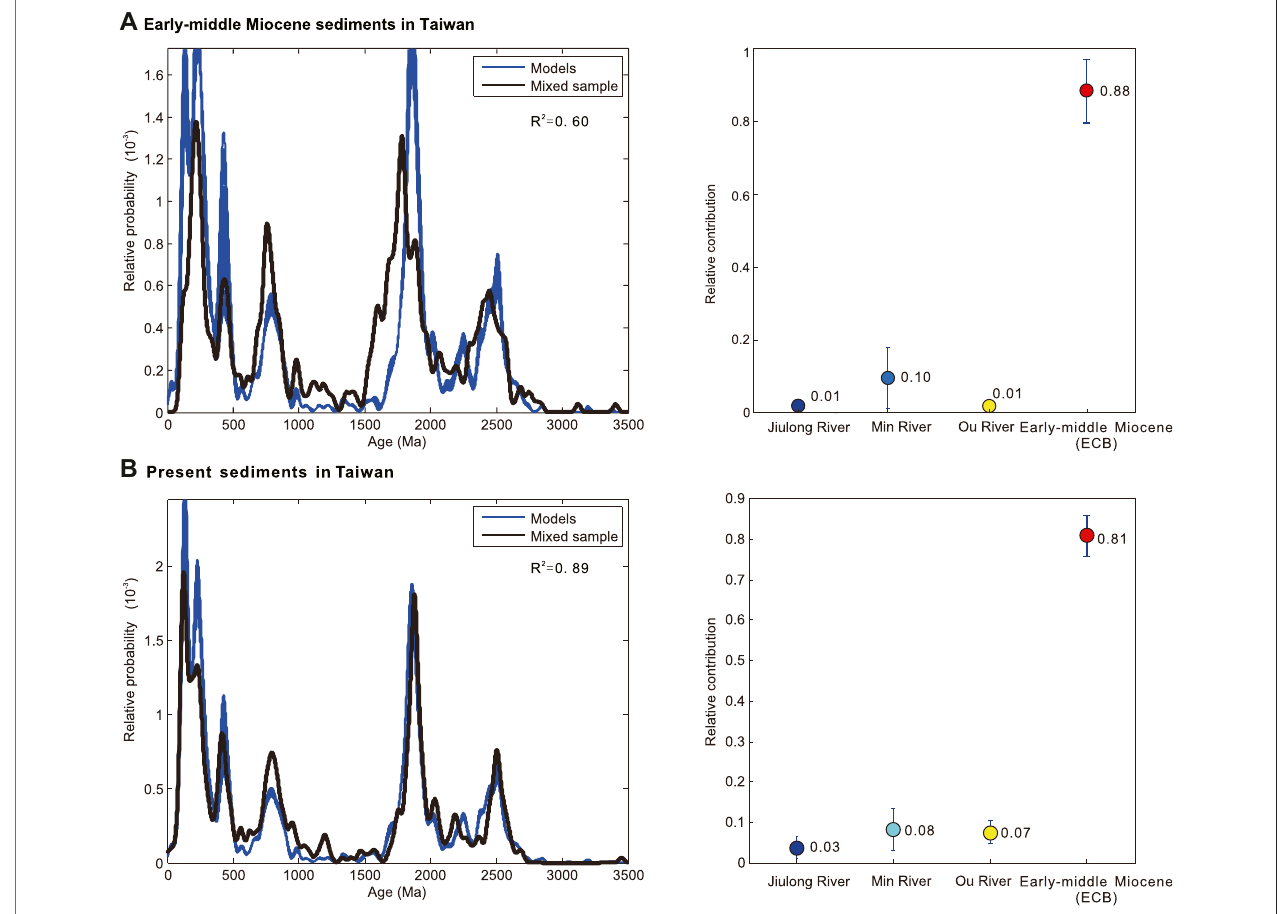
FIGURE 4 | The mixing modelling showing contribution of source areas for early-middle Miocene sandstones and present sediments from Taiwan. The modelling was generated by the Monte Carlo model (Sundell and Saylor, 2017). The Jiulong River, Min River, Ou River and the early-middle Miocene sediments in ECSB were considered as the potential sources to observe the links between sediments in ECSB and the Taiwan. MLYR, middle and lower reaches of the Yangtze River trunk stream; TMYR, tributaries in the middle reaches of the Yangtze River.